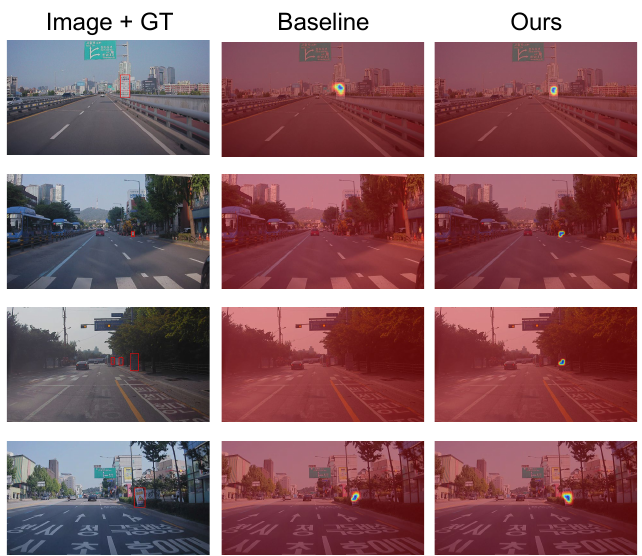
Figure 8. Grad-CAM result. In the first column, input images and corresponding ground truth bonding boxes of the construction sign are shown. In the second and third columns, Grad-CAM results are given. In the Grad-CAM results, high activation values are visualized in blue, while low activation values are visualized in red.